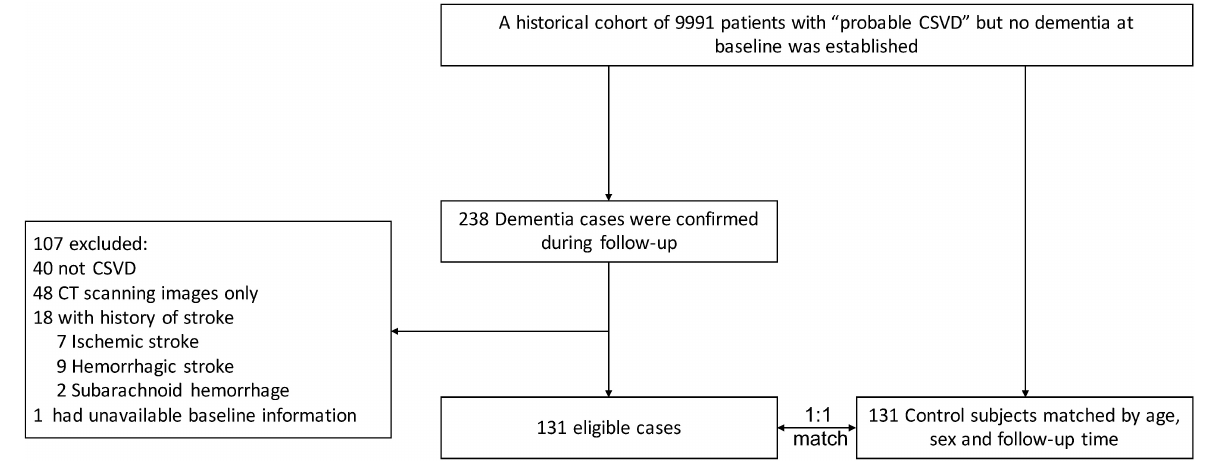
Frontiers in Aging Neuroscience |